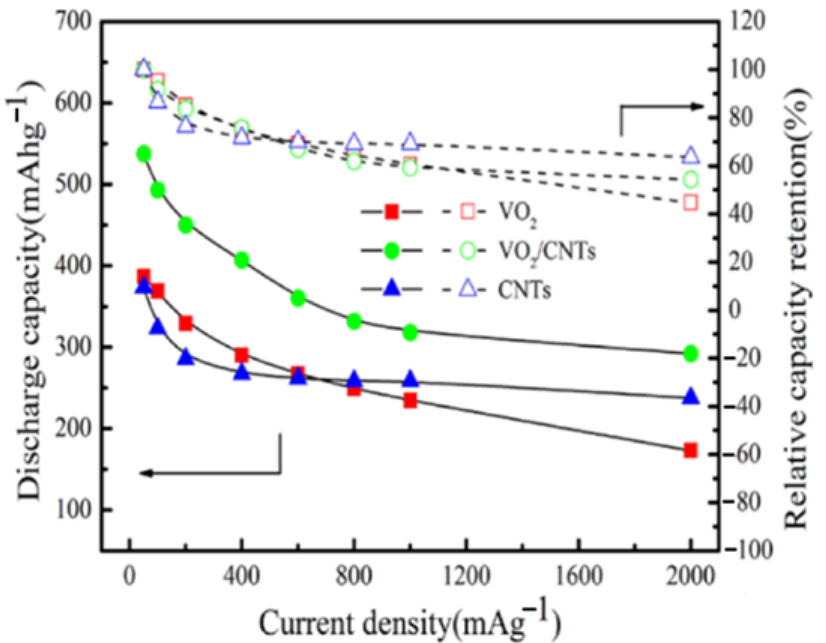
Figure 1. Comparison of the rate capacities and capacity retention of carbon nanotubes (CNTs), VO 2 , and VO 2 /CNTs (Adapted with permission from ref. [32]. Copyright 2018